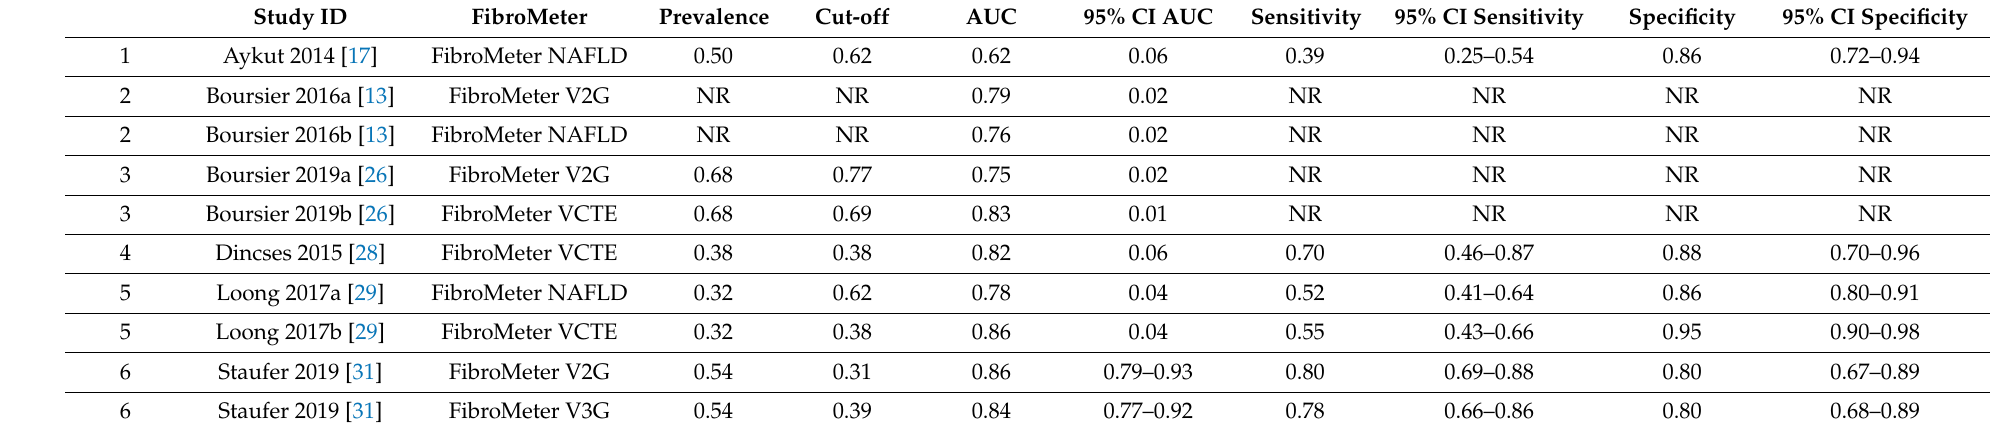
Table 2. Studies reporting AUC of target condition significant fibrosis (F ≥ 2) and their used